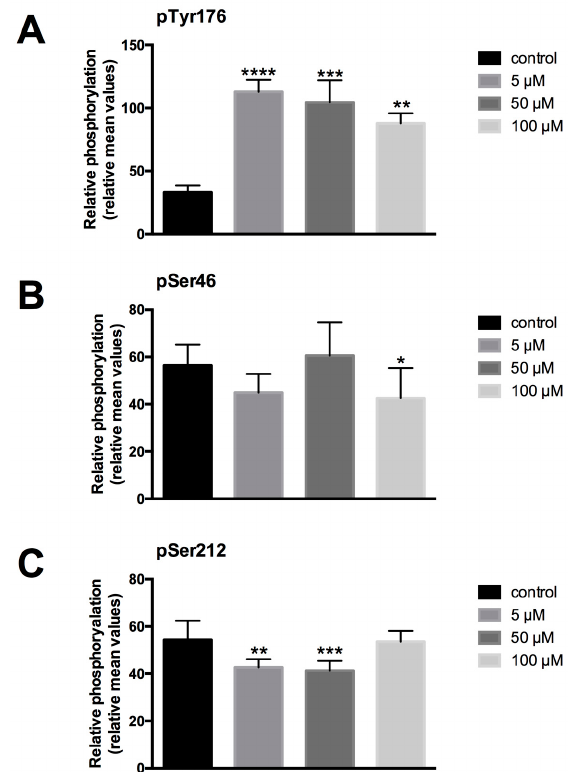
Figure 5. Semiquantitative expression of phospho ‐ Tyr176 ‐ PTPIP51 ( A ), phospho ‐ Ser46 ‐ PTPIP51 ( B ) and phospho ‐ Ser212 ‐ PTPIP51 ( C ) in untreated HaCaT cells and in cells treated for 12 h with 5 μ M, 50 μ M and 100 μ M LDC ‐ 3 ( n = 3). The reaction intensities were recorded by ImageJ [35,36] and